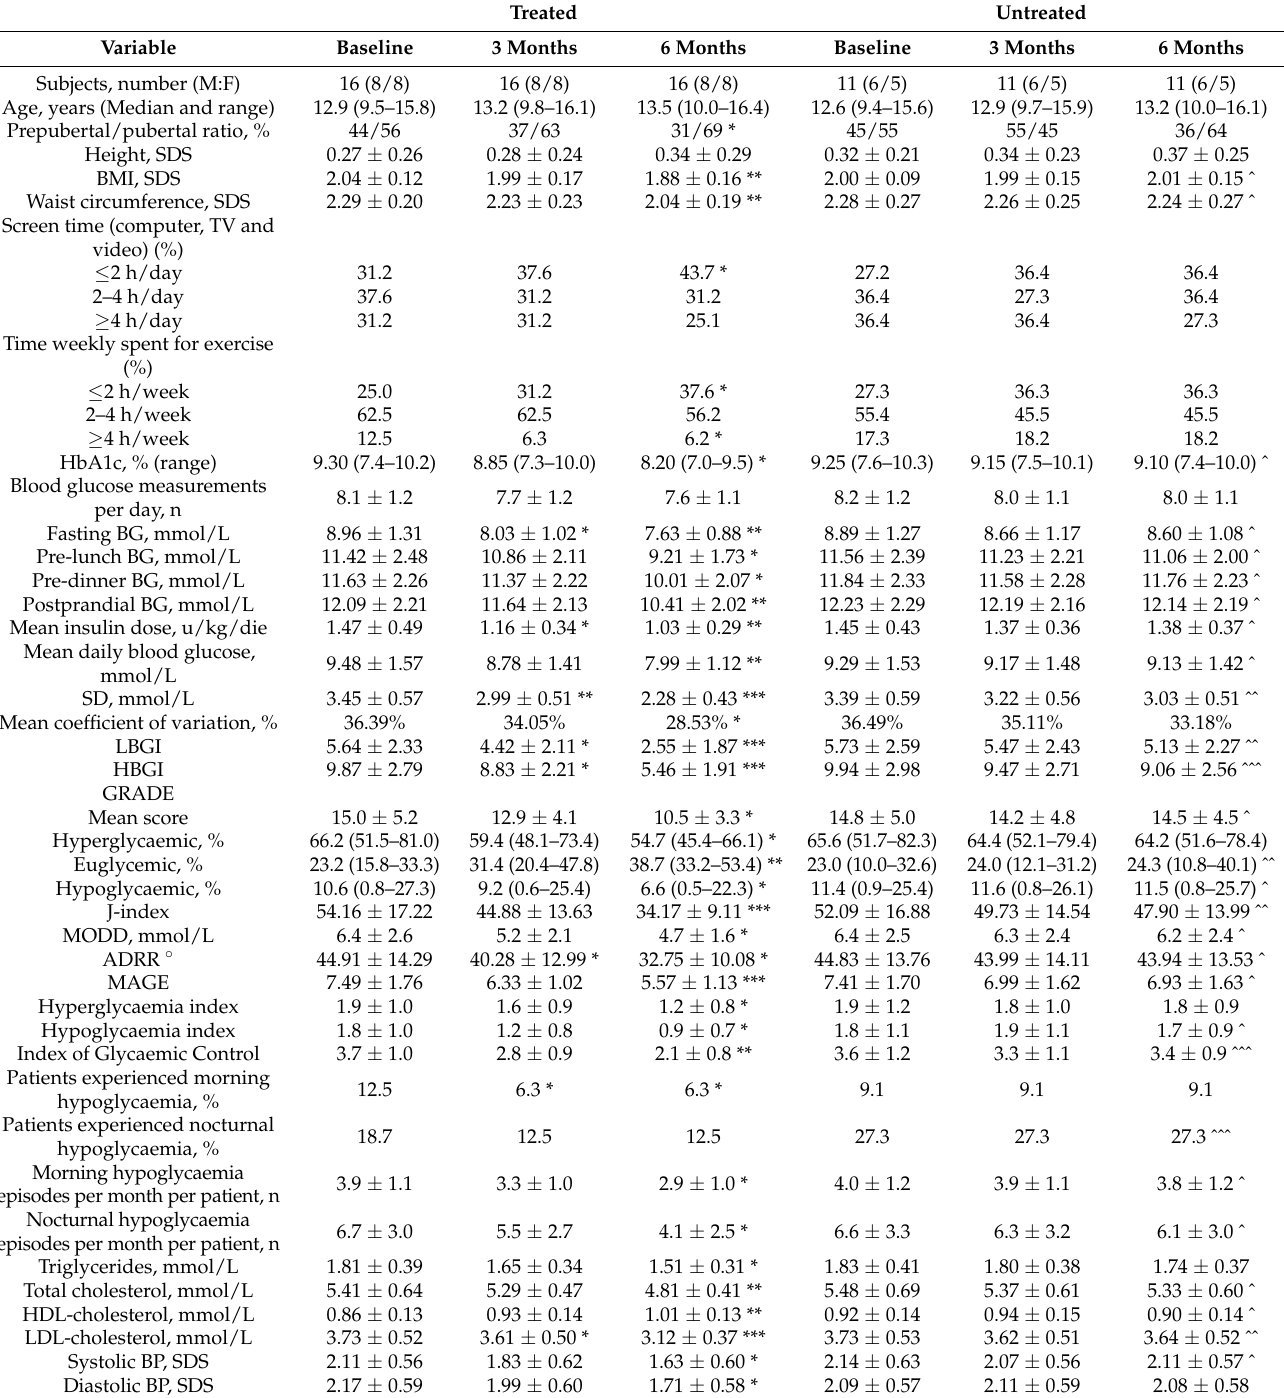
Table 2. Clinical characteristics, glucose variability and hypoglycaemia measurements in children PGR-treated and untreated with type 1 diabetes at baseline and 3 and 6